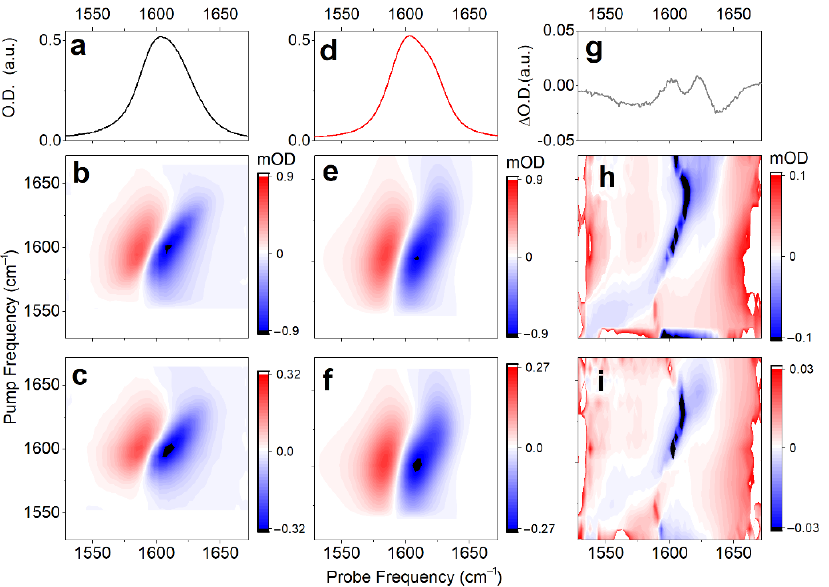
Figure 4. Linear IR ( a ), and 2DIR responses of Cu(L-proline) 2 complex detected at 0.9 ps ( b ), and 2 ps ( c ) time-delays under parallel polarization. Linear IR ( d ) and 2DIR responses ( e , f ) fitted according to a protocol reported previously [41]. ( g – i ) Differences between experimental and fitted spectra for the linear IR and 2DIR responses at 0.9 and 2 ps time-delays, respectively. Table 2. Results of the fit of linear IR and 2DIR experimental spectra using phenomenological fre-